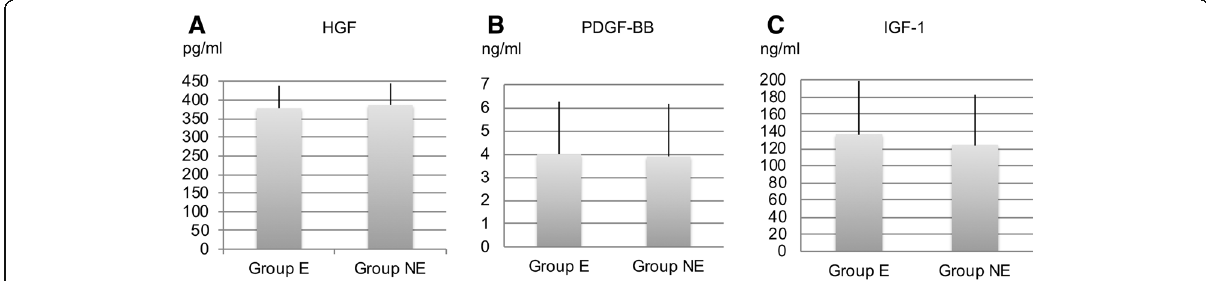
Fig. 1 Concentrations of ( a ) HGF, ( b ) PDGF-BB, and ( c ) IGF-1 in the PRP samples. No significant differences in the concentrations of these growth factors were observed between the E and NE groups ( p > 0.05). Data are presented as the mean ±